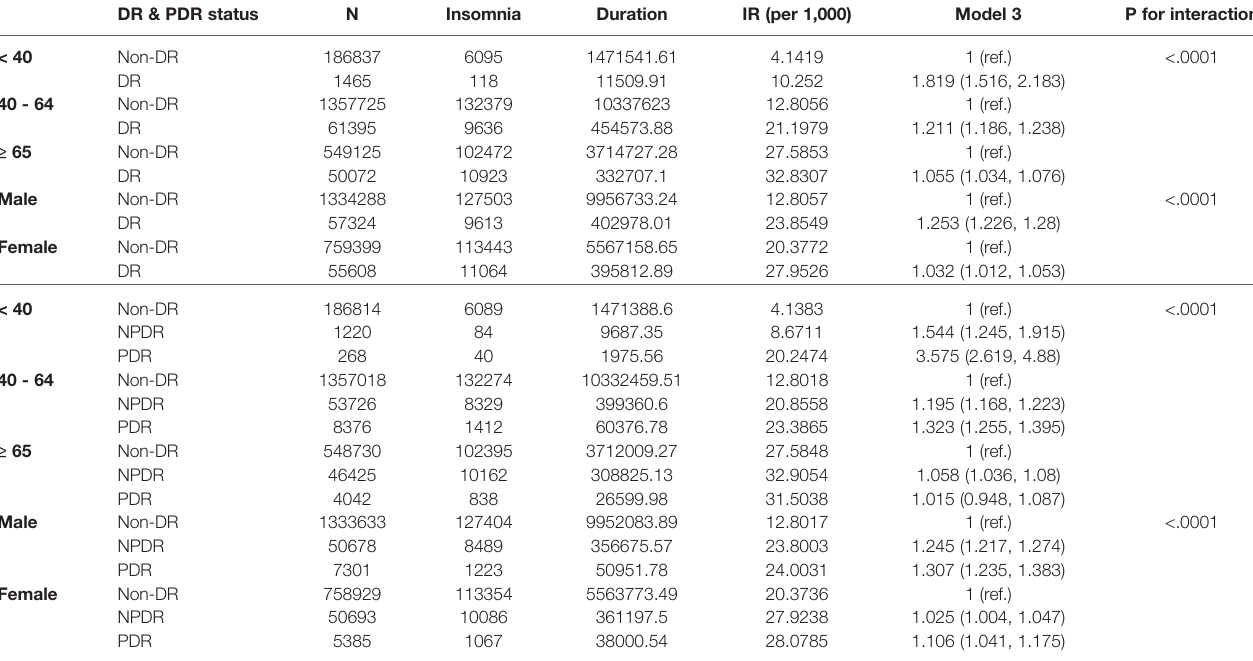
TABLE 3 | Incidence rate (IR) and risk of insomnia in diabetic retinopathy (DR) and proliferative diabetic retinopathy (PDR) with consideration for the interactive effect of age and